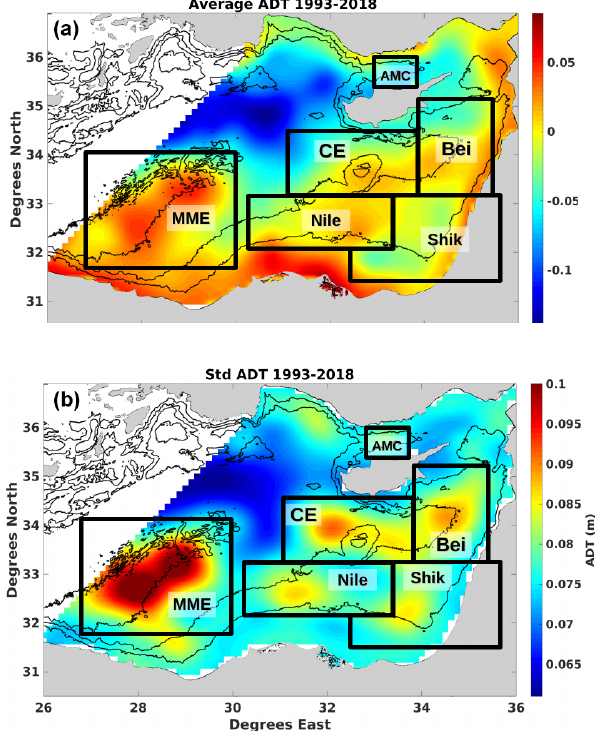
Figure 3. (a) Mean dynamic topography (MDT) between 1993 and 2018 in the eastern Levantine basin. (b) The standard deviation of the absolute dynamic topography (ADT) for the same period. Both include the names and borders of the six delimited sub-regions or boxes (MME: Mersa Matruh Eddy; CE: Cyprus Eddy; Nile; Shik: Shikmona Eddy; Bei: Beirut; AMC: Asia Minor